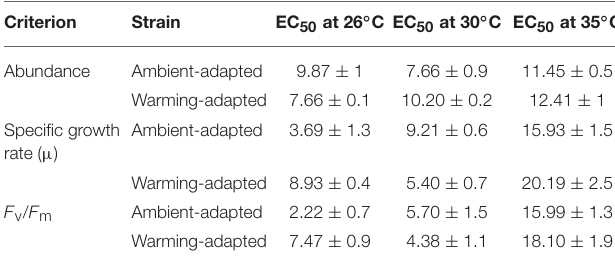
TABLE 2 | 48h Cu EC 50 values ( ± SD) of ambient-adapted and warming-adapted Chaetoceros tenuissimus assayed at 26, 30, and 35 ◦ C. Criterion